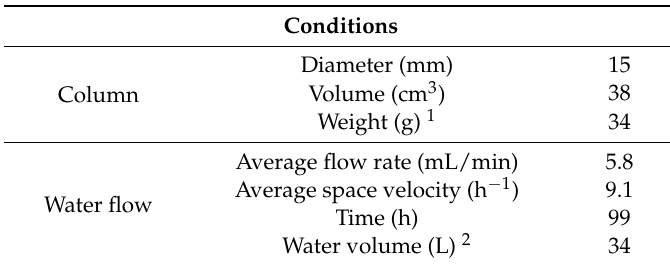
Table 3. Conditions of the simulated treated water passage through the SrTreat ®